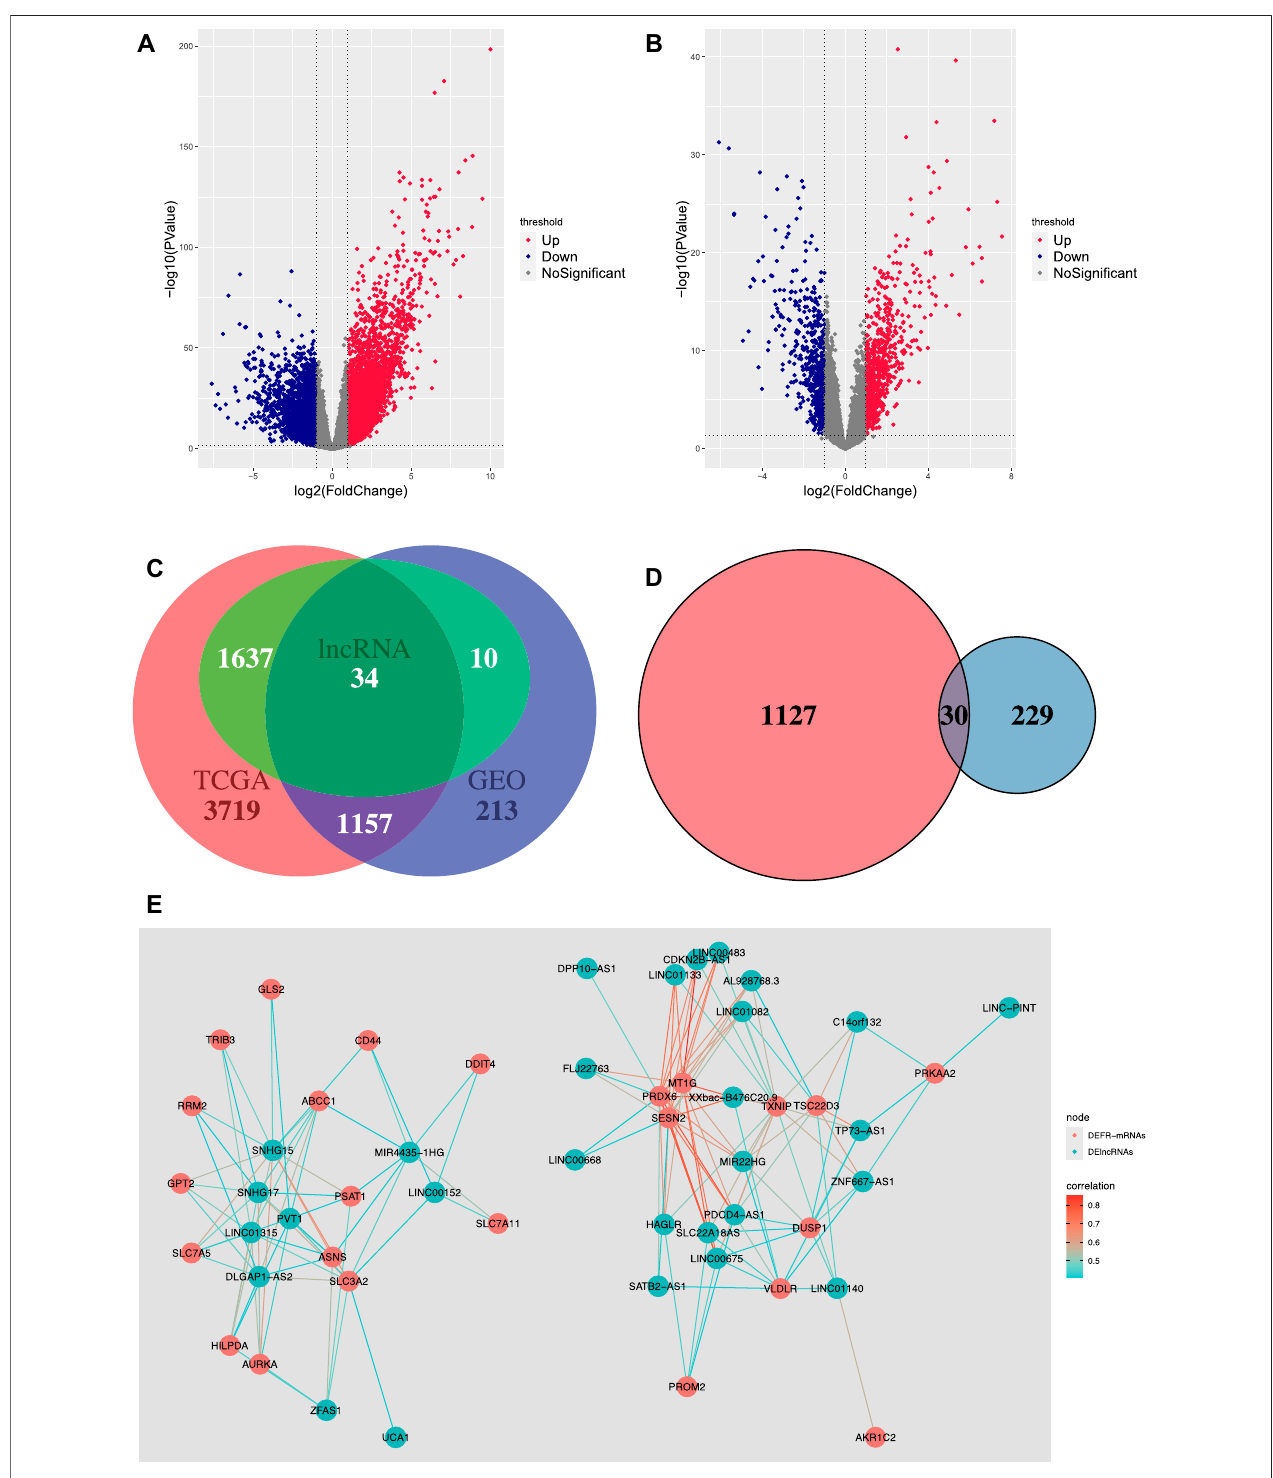
FIGURE 2 | Identi fi cation of DEFR-lncRNAs. (A) Volcano plot of DEmRNAs and DElncRNAs in TCGA-COAD. (B) Volcano plot of DEmRNAs and DElncRNAs in GSE20916. (C) VenndiagramofDEmRNAsandDElncRNAsinTCGA-COADandGSE20916. (D) VenndiagramofthesharedDEmRNAsandferroptosis-relatedgenes. Red represents the shared DEmRNAs between TCGA-COAD and GSE20916, and blue represents the ferroptosis-related genes. (E) Co-expression network between DEFR-mRNAs and DElncRNAs.